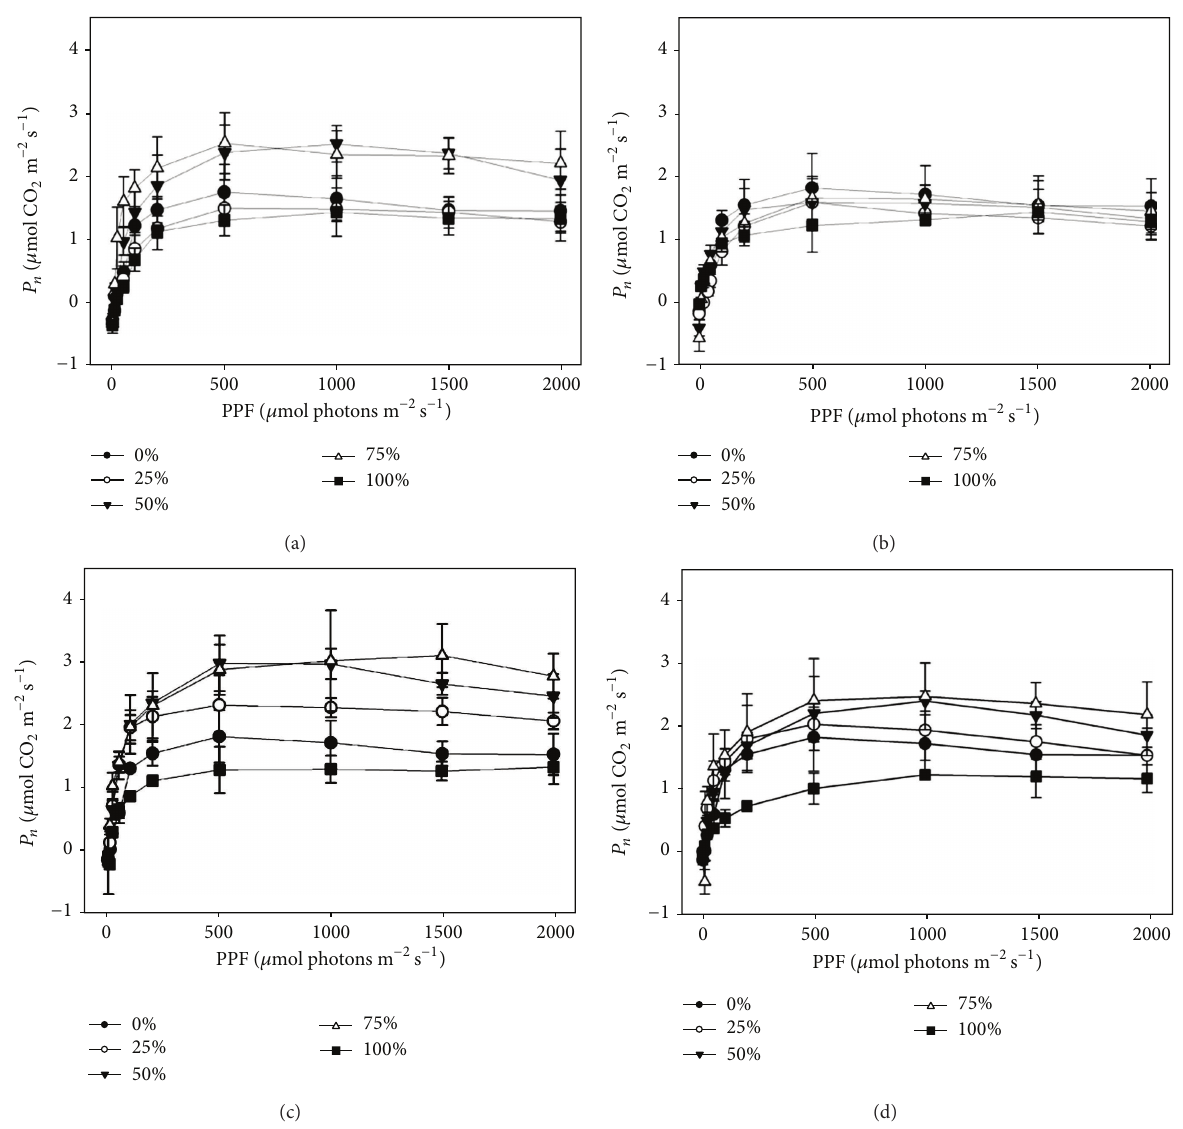
Figure 2: Photosynthetic light-response curves of leaves of Photinia prunifolia colonized with liverworts (a and b) or lichens (c and d), pre- (a and c) versus postremoval (b and d) (mean ± 1 SE) ( 𝑛 = 4 ). Table 1: Effects ( 𝐹 value) of epiphyllous coverage (coverage: 0%, 25%, 50%, 75%, and 100%) and epiphyllous groups (groups: liverworts and lichens) on the leaf traits: leaf mass per area (LMA), leaf water content (LWC), concentration of chlorophyll a (Chl a), Chl b, Chl a + b, and Chl a/b of Photinia prunifolia in JNNR. df